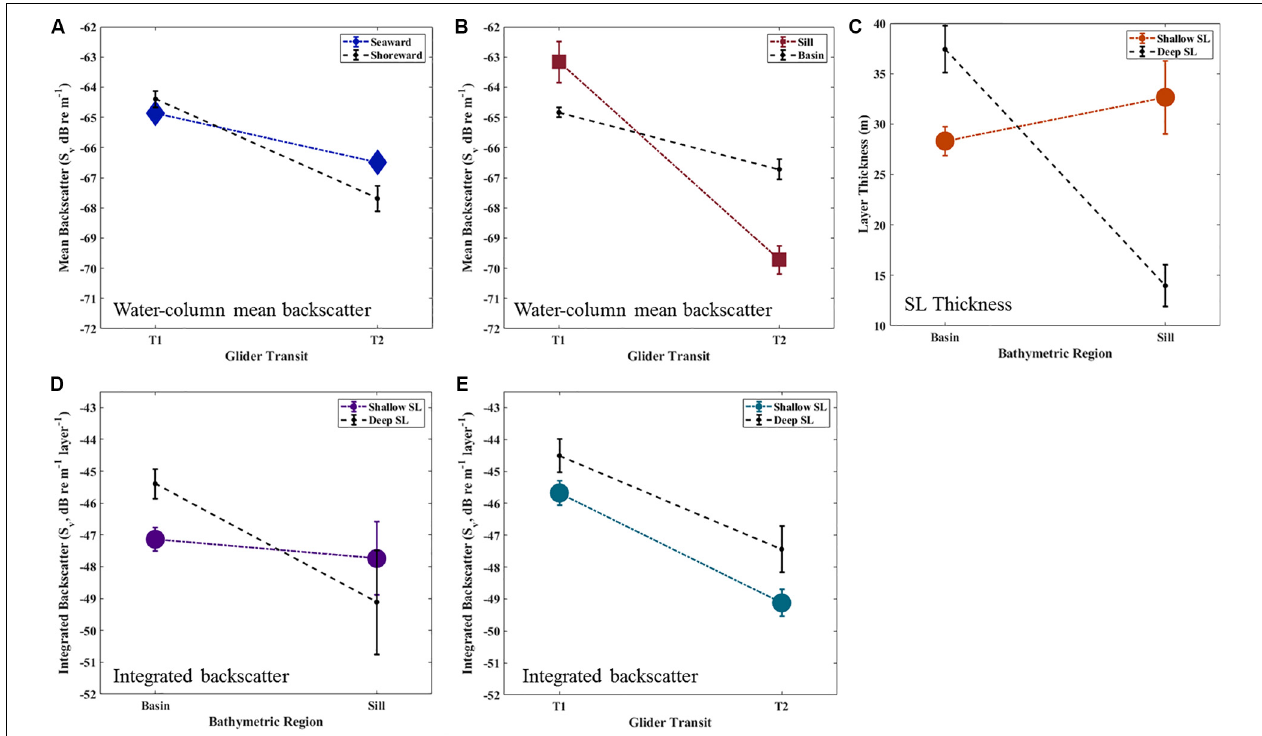
FIGURE 7 | Significant two-way interactions (A–D) and significant within-transit difference (E) with standard error for mean backscatter (S v , dB re 1 m − 1 ; panels (A,B) ; averaged over SL type, giving the water column mean), SL thickness (m; C ), and integrated backscatter (S v , dB layer − 1; D,E